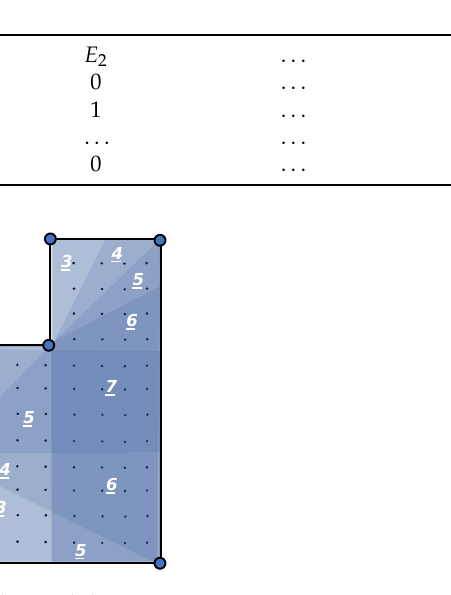
Figure 4. Discretized heatmap for the edge visibility.